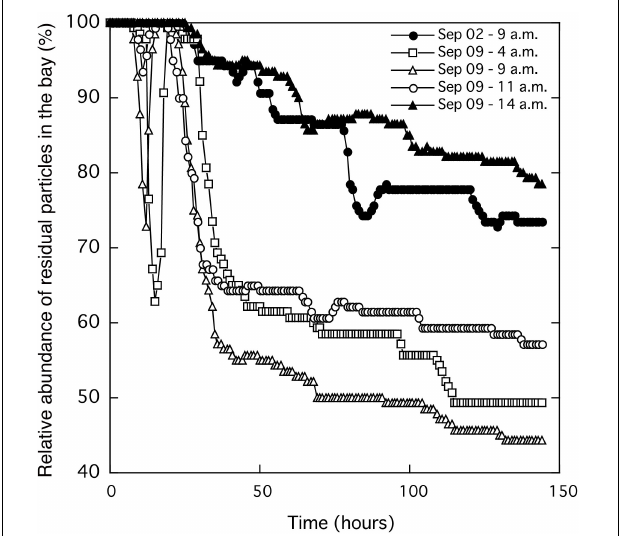
FIGURE 5 | Relative abundance (%) of residual particles in Sagami Bay after releasing particles from the shoreline at different time intervals based on the typhoon passage: 1 week before (09:00 September 2nd), 2 h after (04:00 September 9th), 7 h after (09:00 September 9th), 9 h after (11:00 September 9th) and 12 h after (14:00 September